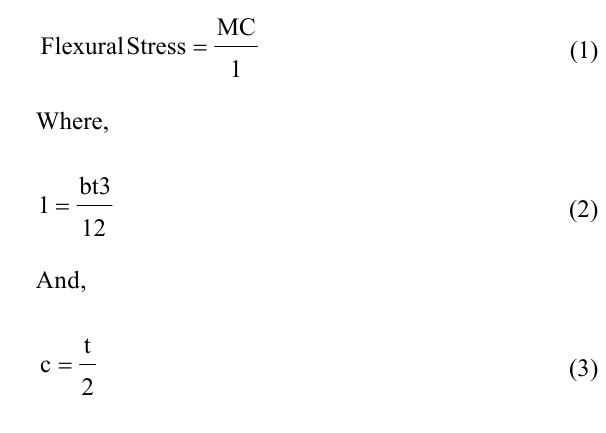
TABLE 2. MECHANICAL PROPERTIES OF